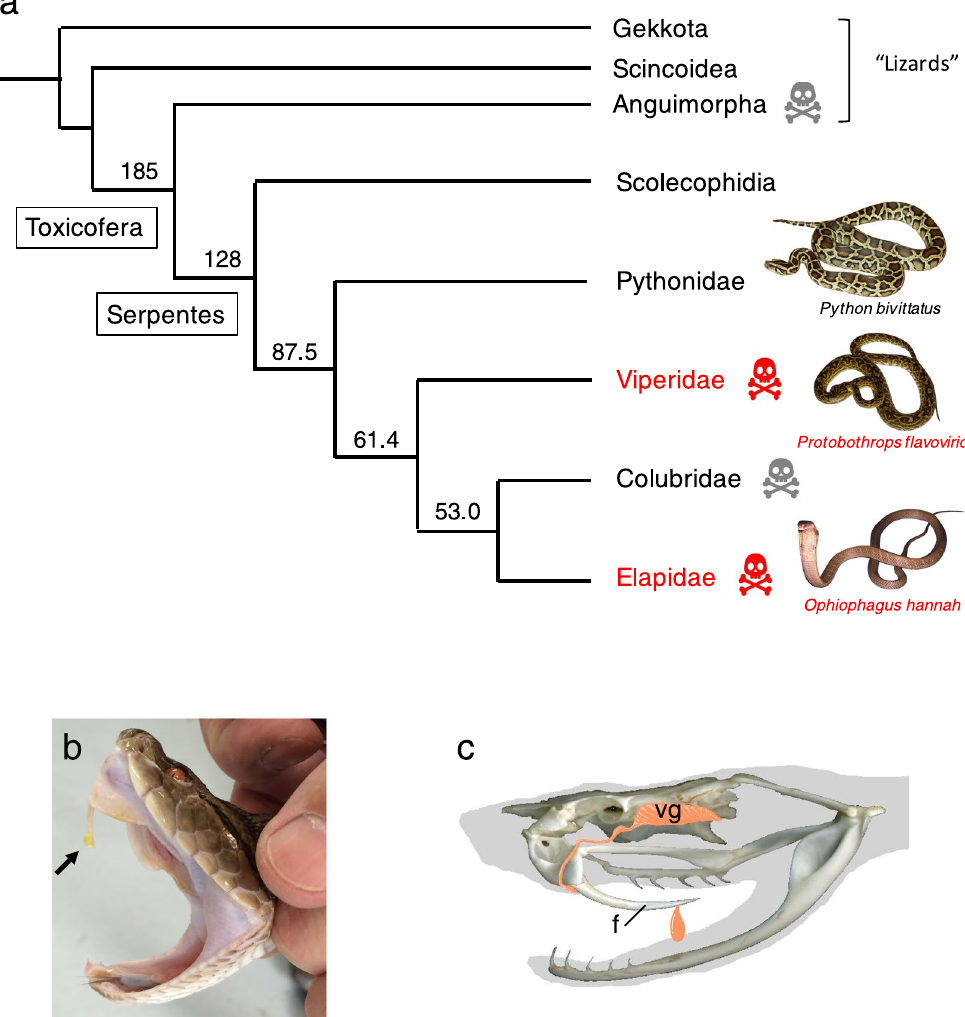
Figure 1. Squamate phylogeny and postorbital venom glands. ( a ) Simplified phylogenetic relationships between major clades of snakes with non-snake squamates. Numbers at nodes denote estimated divergence times in millions of years (based on Zheng and Wiens (2016)). Two entirely venomous clades, Viperidae and Elapidae are indicated with skull-and-crossbones in red. Two partially venomous clades, Anguimorpha and Clubridae are indicated with skull-and-crossbones in grey. The three clades in which draft genome sequences have been reported are shown with pictures, the Burmese Python, Python bivattatus [Castoe et al . 16 ], the habu, Protobothrops flavoviridis (this study) and the king cobra, Ophiophagus hannah [Vonk et al . 12 ]. Images of the Burmese python and the king cobra were provided by Koki Terada of the Okinawa Prefectural Institute of Health and Environment, Okinawa, Japan. ( b ) Habu venom (arrow) dripping from the fang. ( c ) A drawing of the fang ( f ) and the postorbital venom gland (vg) of P . flavoviridis